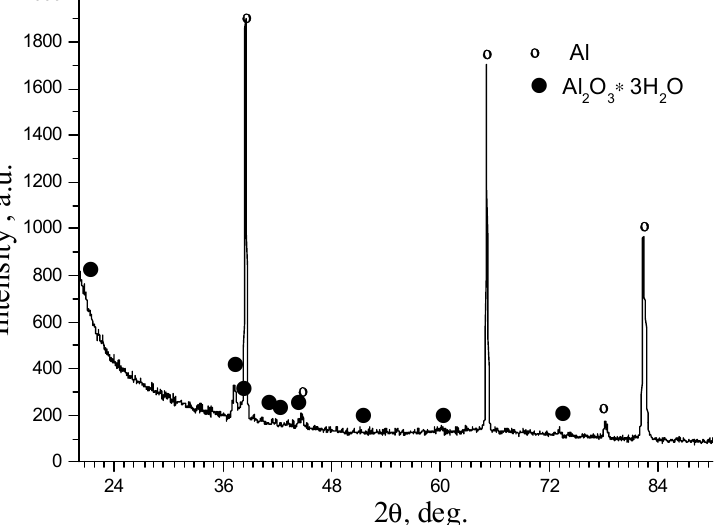
Figure 8. Typical phase composition of hard anodized layers synthesized for 1 h at at an electrolyte temperature of − 4–0 °C.